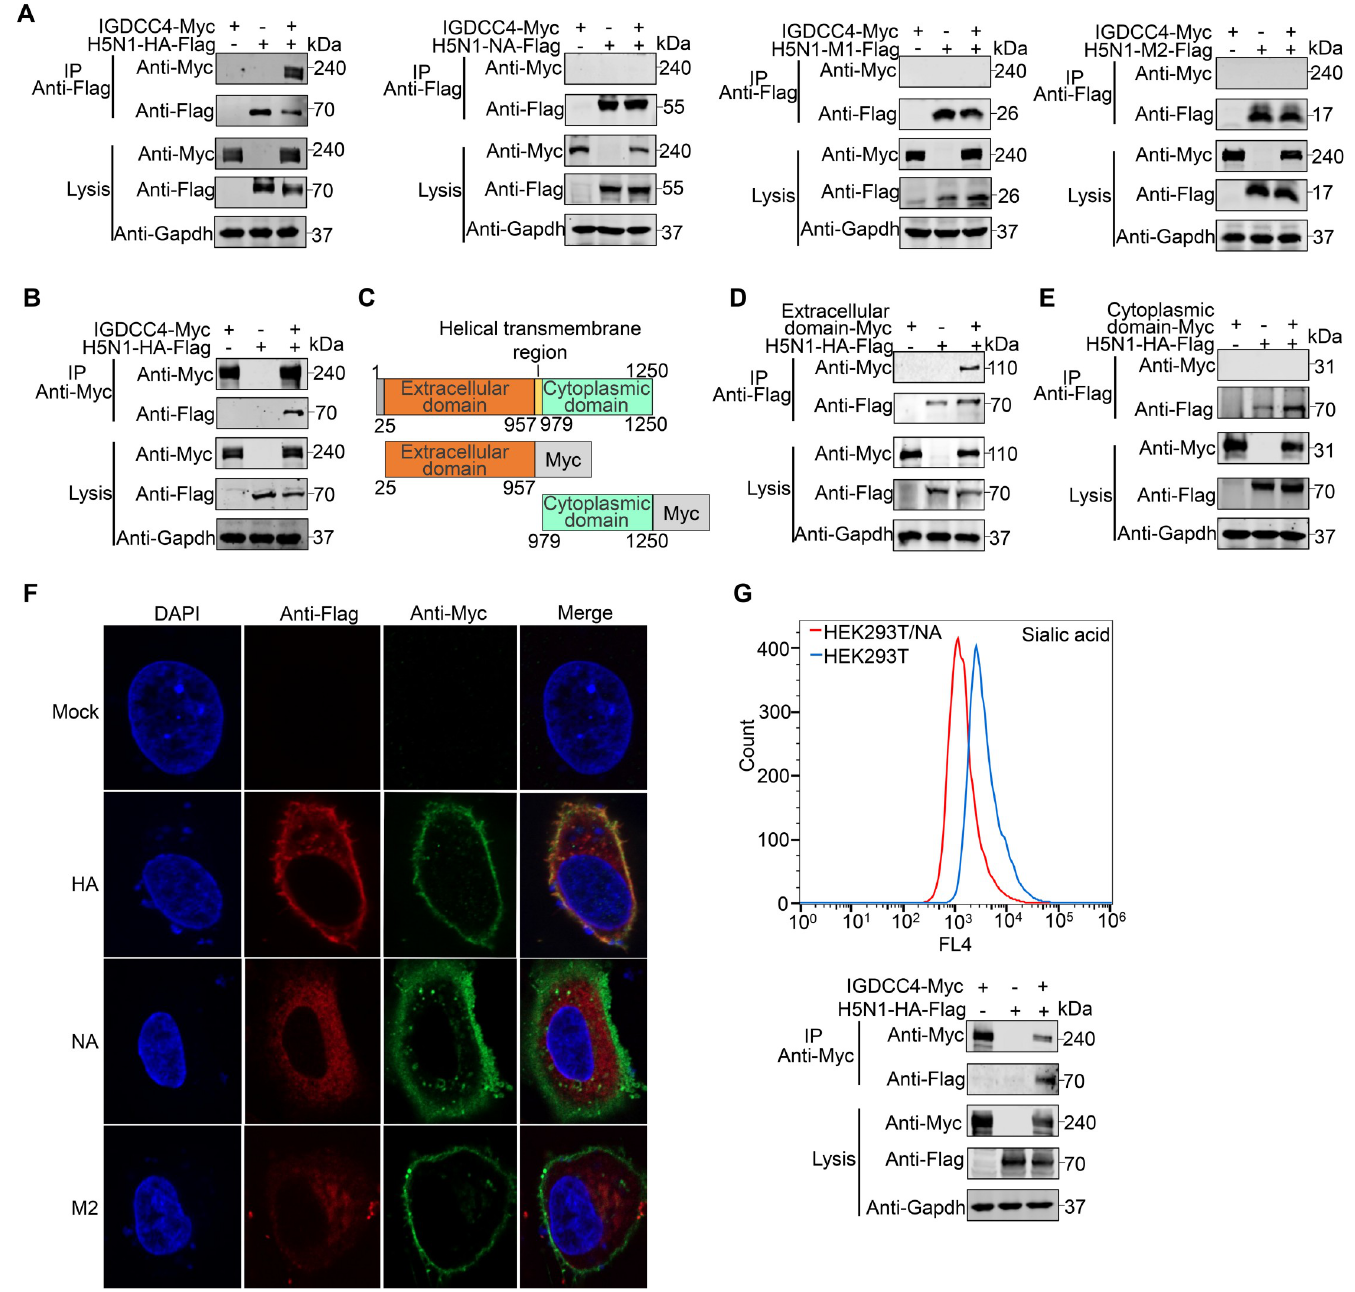
Fig 5. IGDCC4 interacts with the HA protein of influenza virus. ( A ) Interaction of IGDCC4 with the HA, NA, M1, and M2 proteins of H5N1 virus. HEK293T cells were transfected individually or in combination with plasmids for the expression of IGDCC4 fused with Myc tag and viral proteins fused with Flag tag. ( B ) IGDCC4 interaction with the HA protein of H5N1 virus was confirmed by immunoprecipitation with the anti-Myc antibody. ( C ) Schematic presentation of IGDCC4. ( D ) The extracellular domain of IGDCC4 interacts with the HA of H5N1 virus. ( E ) The endocytic domain of IGDCC4 does not interact with the HA of H5N1 virus. ( F ) A549 cells were co-transfected with a plasmid expressing IGDCC4 and a plasmid expressing HA, NA, or M2 of H5N1 virus, and the interaction of IGDCC4 with these proteins was confirmed by using a colocalization assay. ( G ) The HA of H5N1 virus interacted with IGDCC4 expressed in HEK293T cells treated with neuraminidase. The data shown are representative of three independent